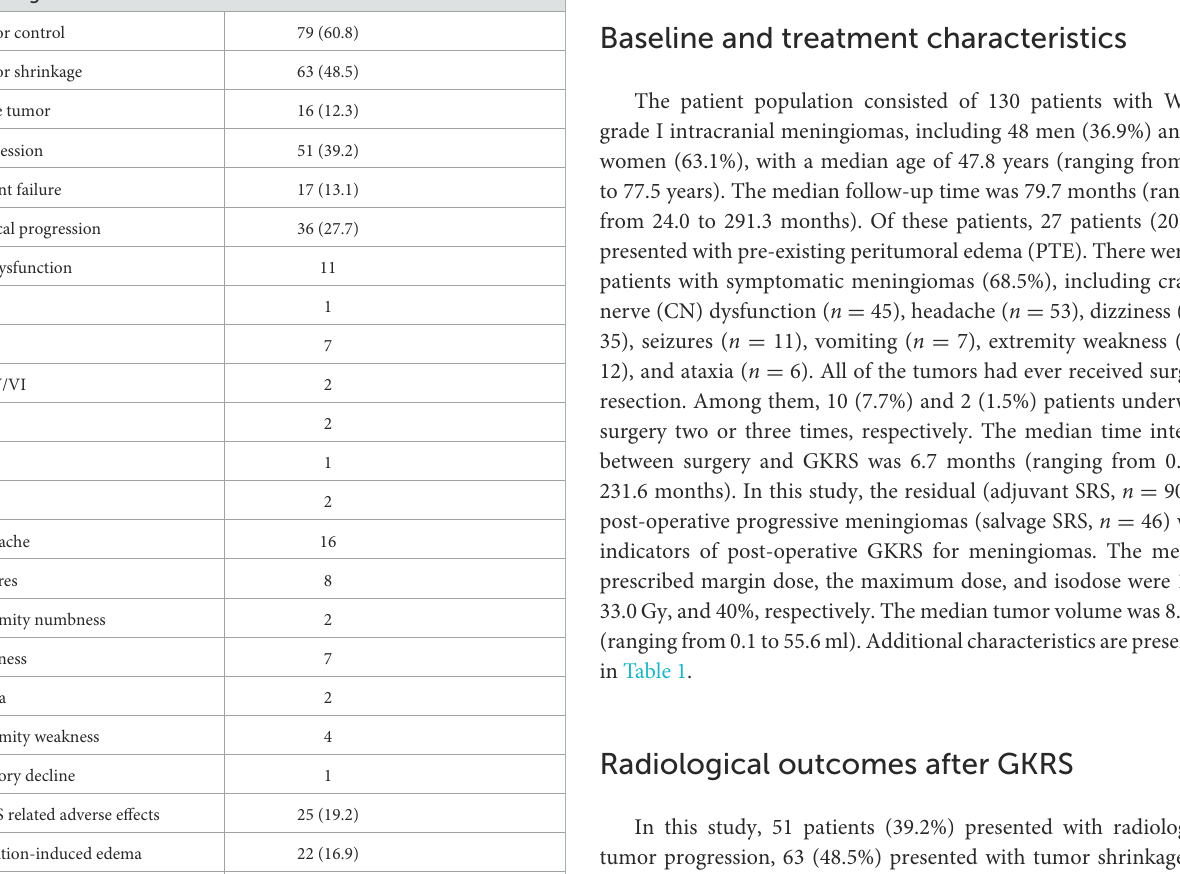
falx/parasagittal/convexity/intraventricular location ( p = 0.047) (Figure 2B) were significantly associated with radiological tumor progression. In the multivariate analysis, a tumor volume of ≥ 10 ml and